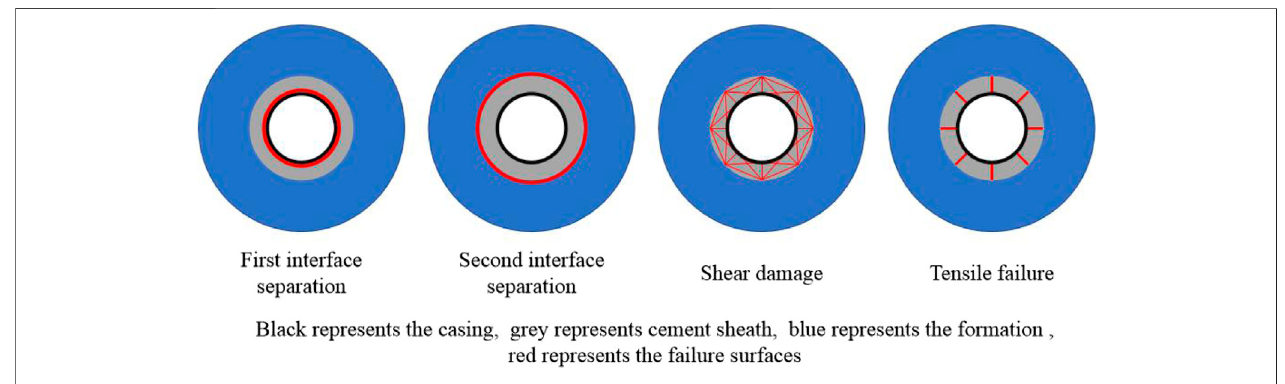
FIGURE 2 | Failure types of the cement